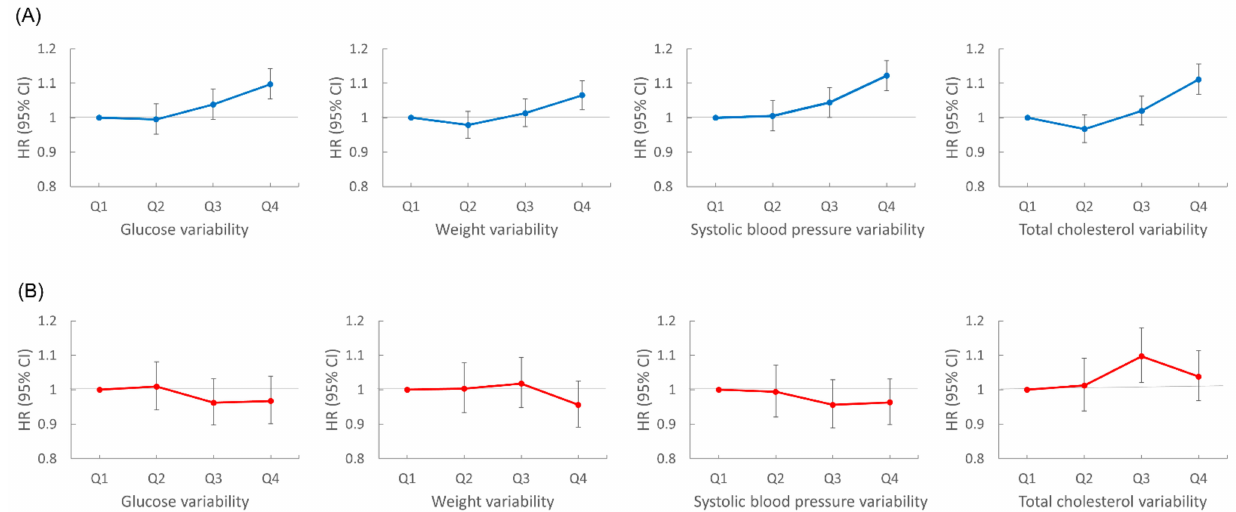
Figure 4. Sex stratified analyses of lung cancer risk according to variability of metabolic parameters. All hazard ratios (HR) are adjusted for age, alcohol consumption, smoking, regular exercise, household income, baseline fasting blood glucose, total cholesterol, systolic blood pressure, and body mass index. ( A ) Risk of lung cancer in men according to glucose, weight, systolic blood pressure, and total cholesterol variability. ( B ) Risk of lung cancer in women according to glucose, weight, systolic blood pressure, and total cholesterol